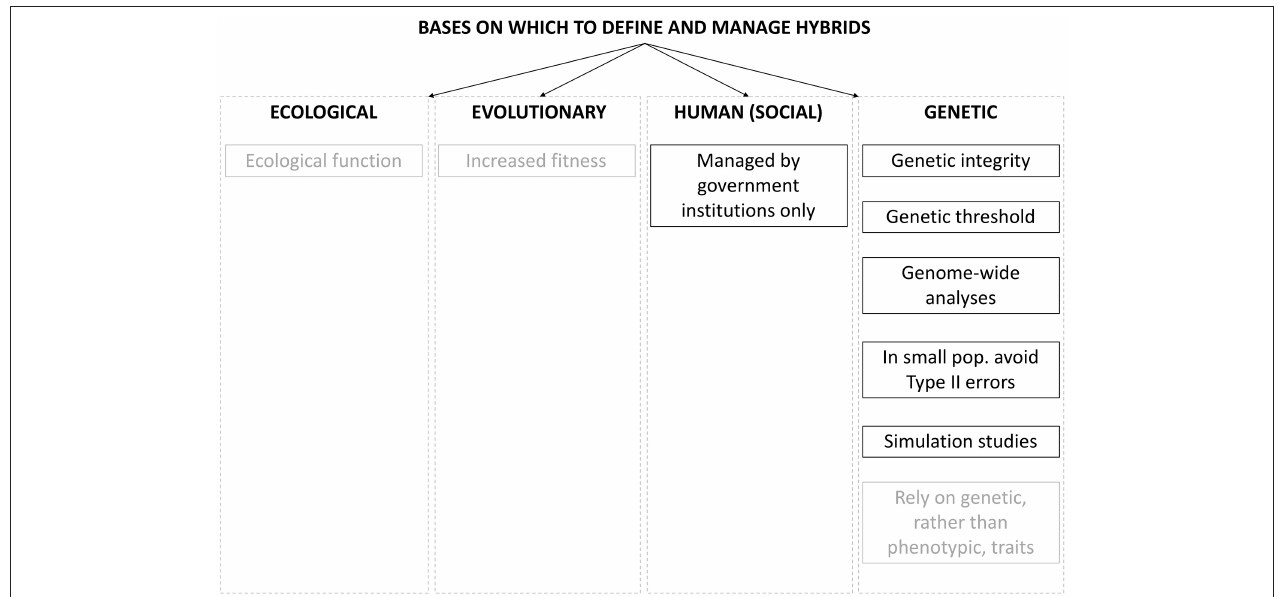
FIGURE 4 | Visual representation of conceptual areas of wolf x dog hybridization where consensus was reached, in a Delphi study with a group of selected experts ( n = 42). Four dimensions/bases (i.e., Ecological, Evolutionary, Human, Genetic) are adopted to characterize definition issues, and their respective management implications (in the boxes underneath them). Boxes outlined in black reached consensus (i.e., at least 27/42 experts agreeing). Boxes faded-in did not reach consensus, and the respective topics they address need to be particularly emphasized in discussions and symposium settings, to aid effective management.